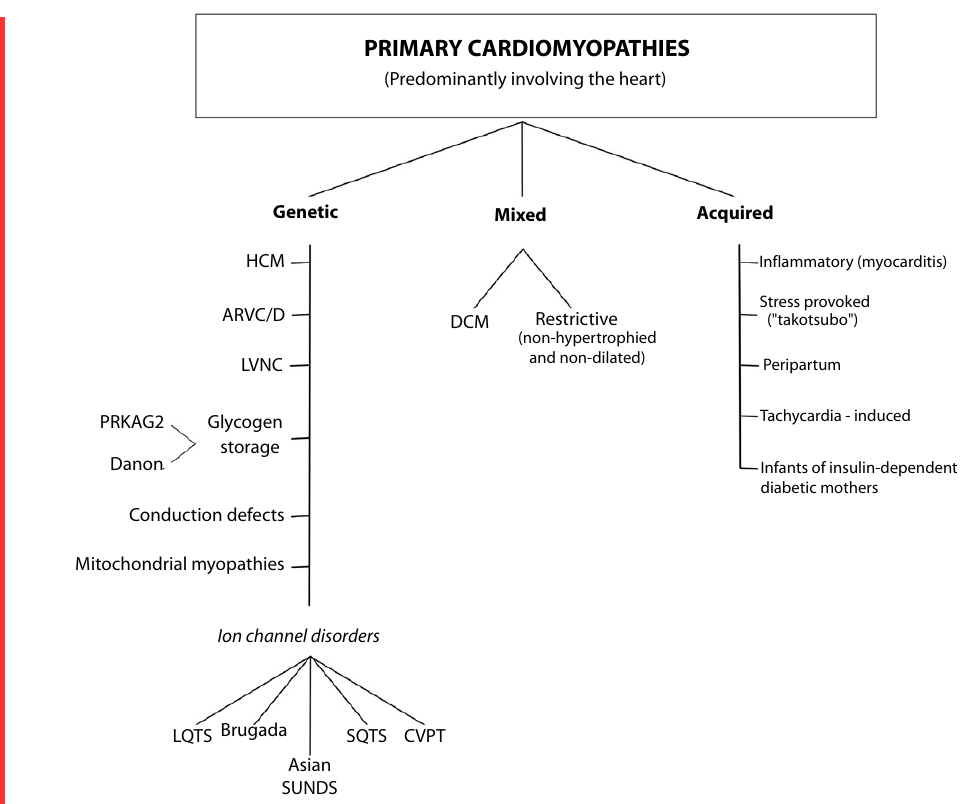
Figure 1. Classification of the cardiomyopathies – American Heart Association. Modified from